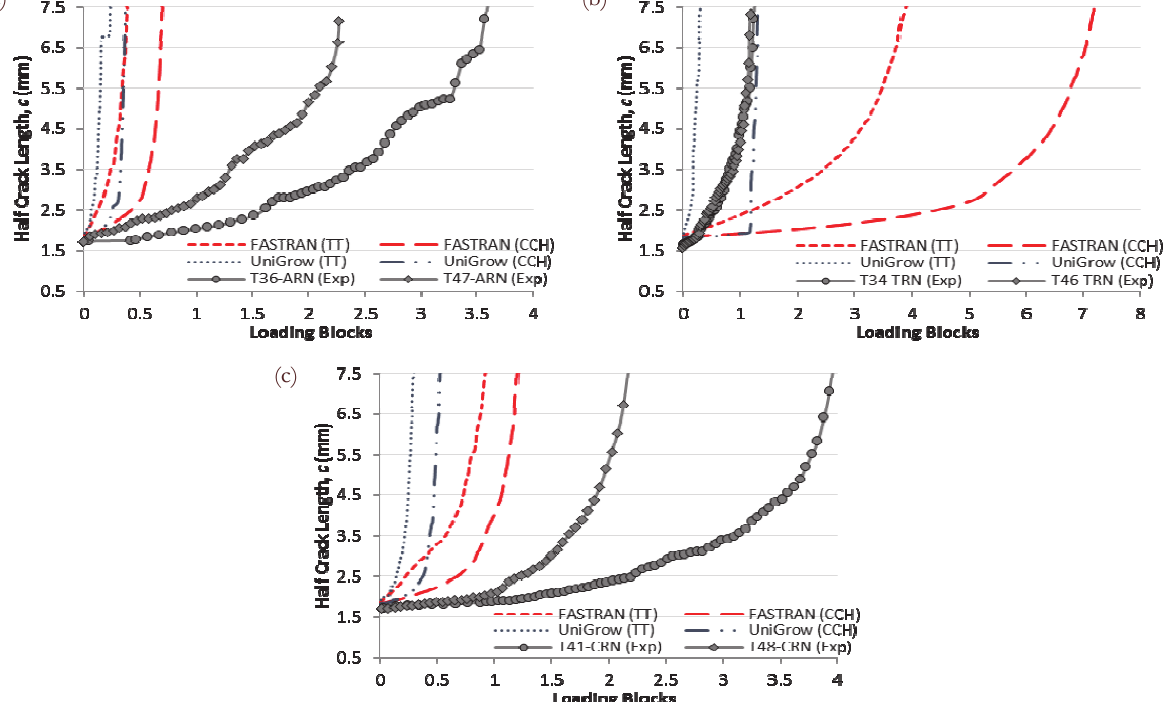
Figure 4: Variable amplitude crack growth curves for lowest loading level (a) axial, (b) torsion, and (c) combined axial-torsion